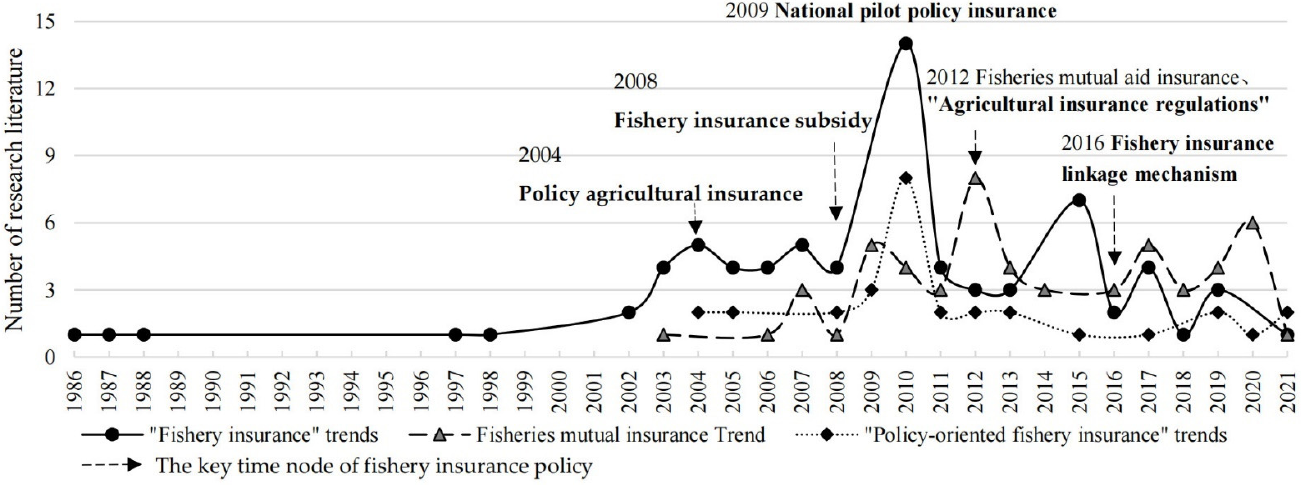
Figure 1. Text statistics of fishery insurance-related research.